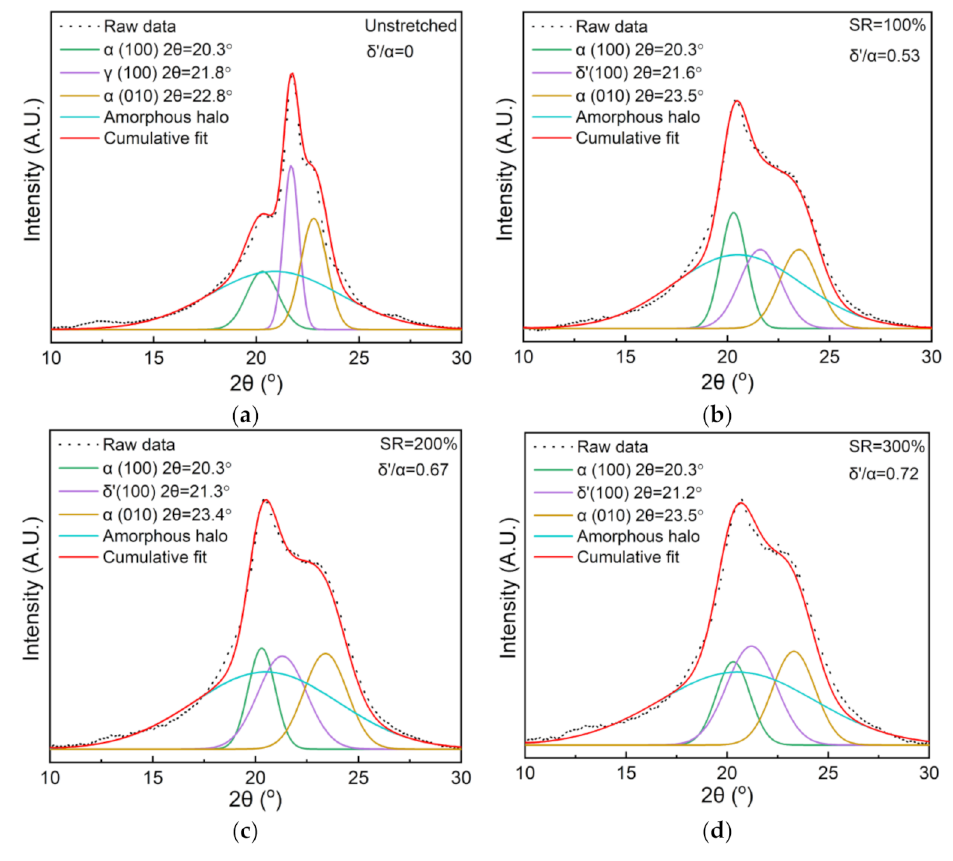
Figure 2. XRD fitting curves for the diffraction peaks of the unstretched and stretched nylon-11 films: